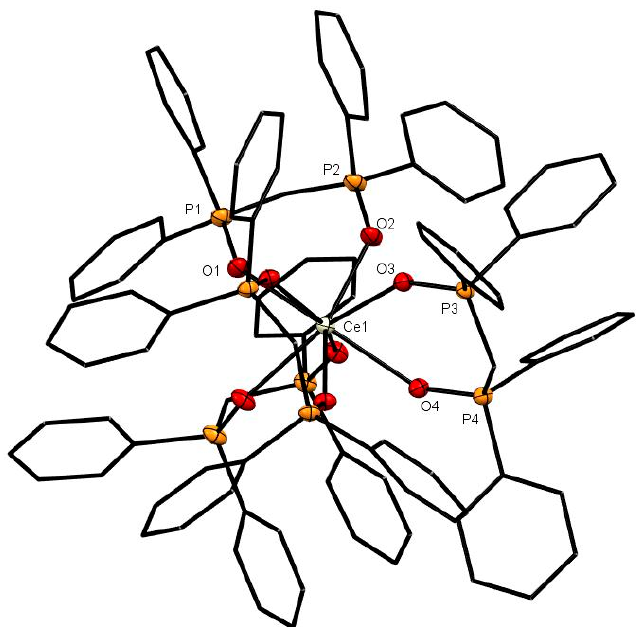
Figure 1. The cation in [Ce(dppmO 2 ) 4 ]Cl 3 . The chloride anions and solvate molecules are omitted. Selected bond lengths (Å): Ce1–O1 = 2.4874(14), Ce1–O2 = 2.4790(14), Ce1–O3 = 2.4967(13), Ce1–O4 = 2.4803(14), P1–O1 = 1.5031(14), P2–O2 = 1.5021(14), P3–O3 = 1.5018(14), P4–O4 = 1.5031(14). Chelate angle O-Ce-O = 73.1° (av).